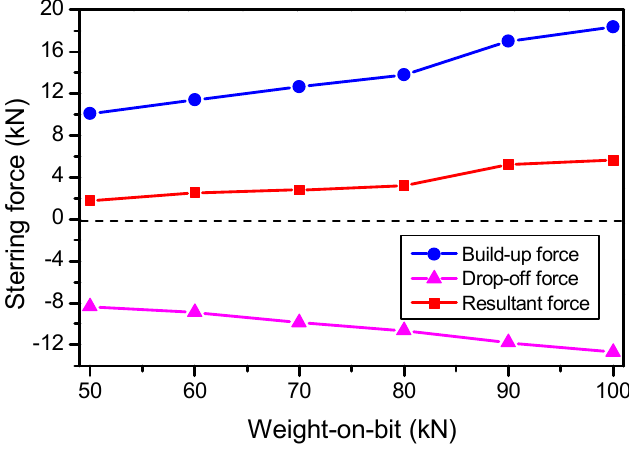
Figure 14. Steering force versus weight-on-bit (WOB).